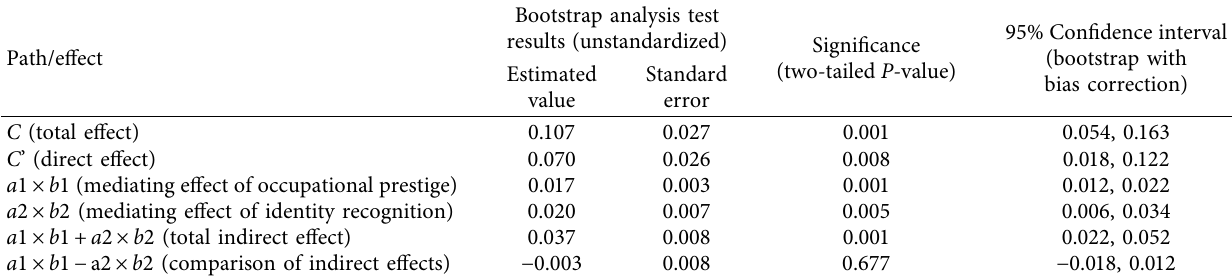
Table 3: Results of the bootstrap test analysis for the significance of the mediation